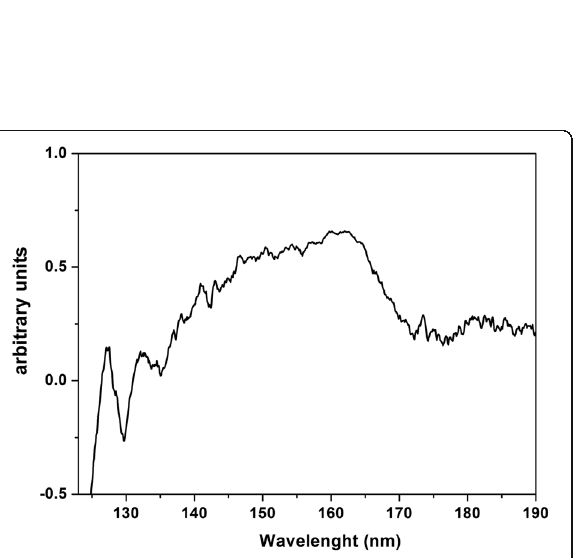
Fig. 7 XRD spectra of a PrF 3 and b LaF 3 NPs. The mean surface area diameters of PrF 3 and LaF 3 NPs were ~ 23 ± 4 and ~ 15 ± 4 nm, respectively